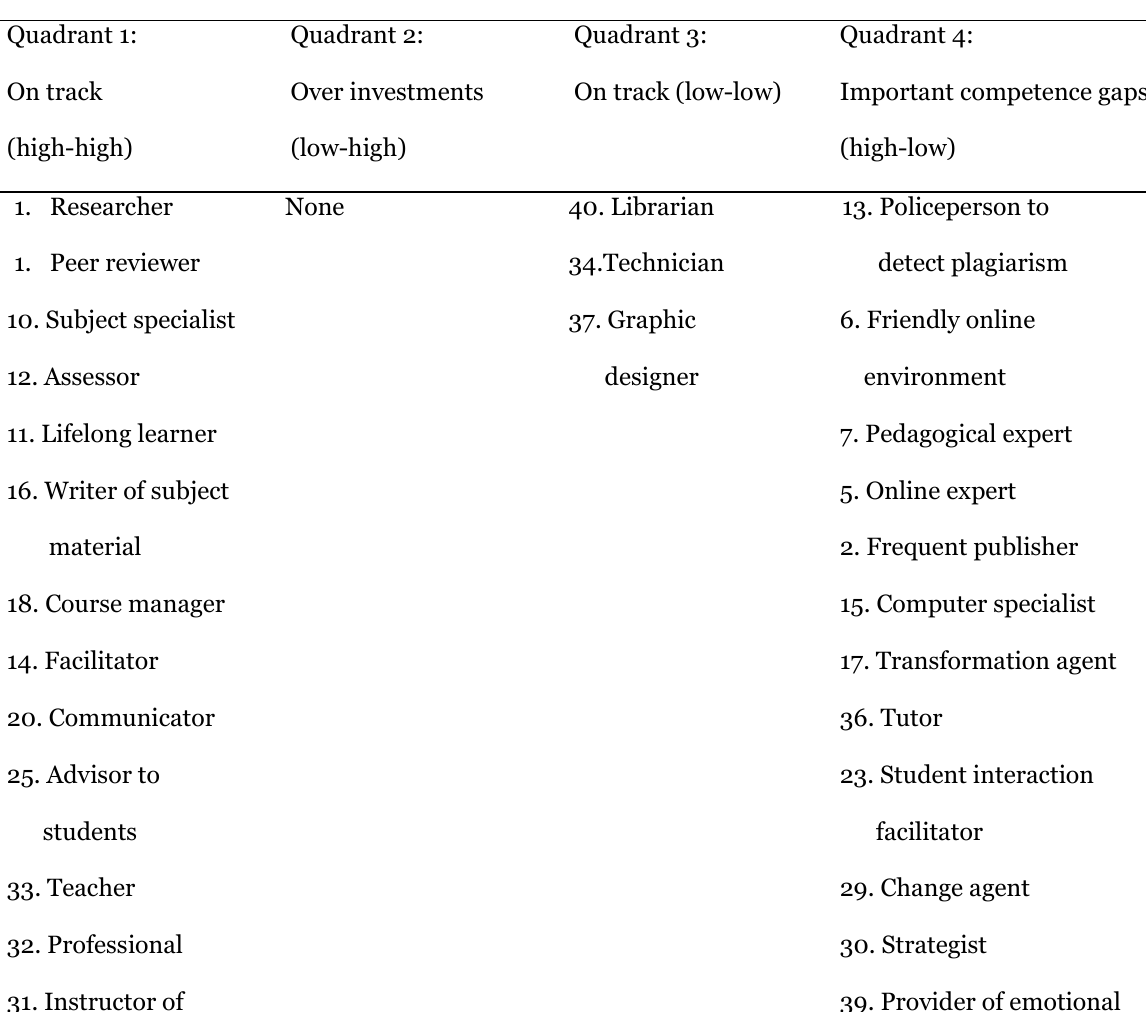
The Perceived Importance-Competence Gap of Specific Academic Work Roles (N=141) Quadrant